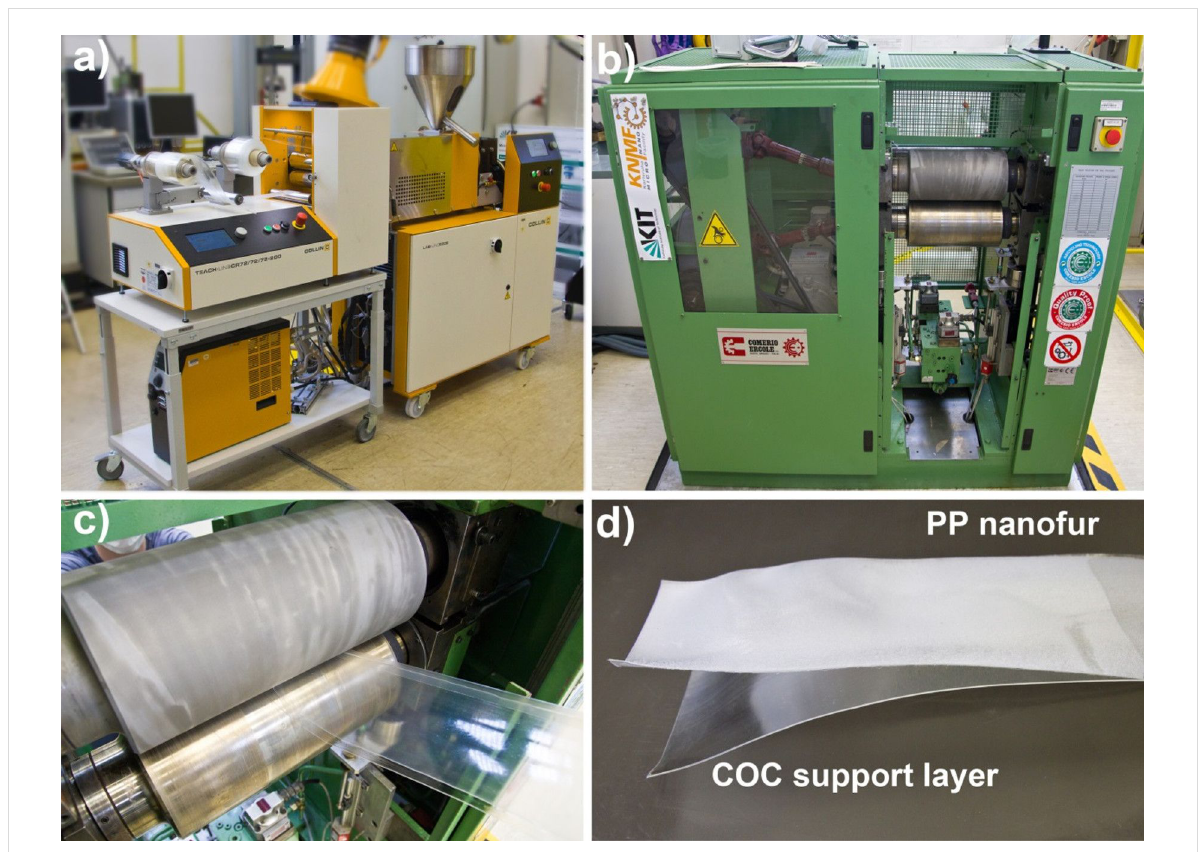
Figure 2: Photos showing the essential fabrication steps of thin nanofur. (a) Extrusion line with rolling unit to co-extrude the thin PP film onto the COC support film. The right roll is the coiled COC film; the left one is the completed PP/COC laminate. (b) Photo of the lab calender utilized to structure the PP film. (c) Close-up of the rollers of the lab calender. In this machine the upper sandblasted roller is heated and gets in contact with the PP side of the laminate. In this way, the nanofur hairs are pulled out of the PP film. The lower roller is smooth and not heated, but presses the film sandwich against the upper sandblasted roller. (d) Finally, PP and COC are separated through peeling.